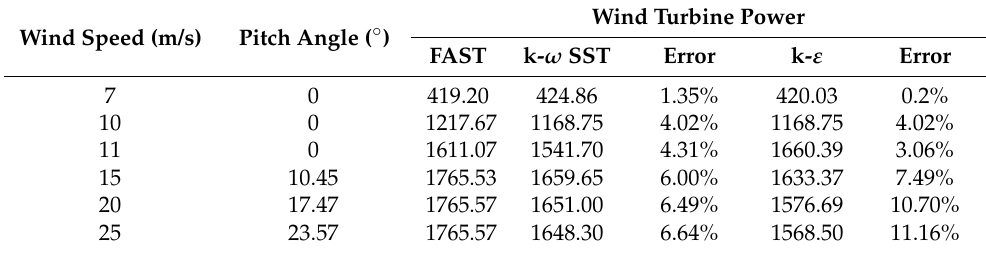
Table 4. Output power based on the k- ω SST and k- ε models and FAST.